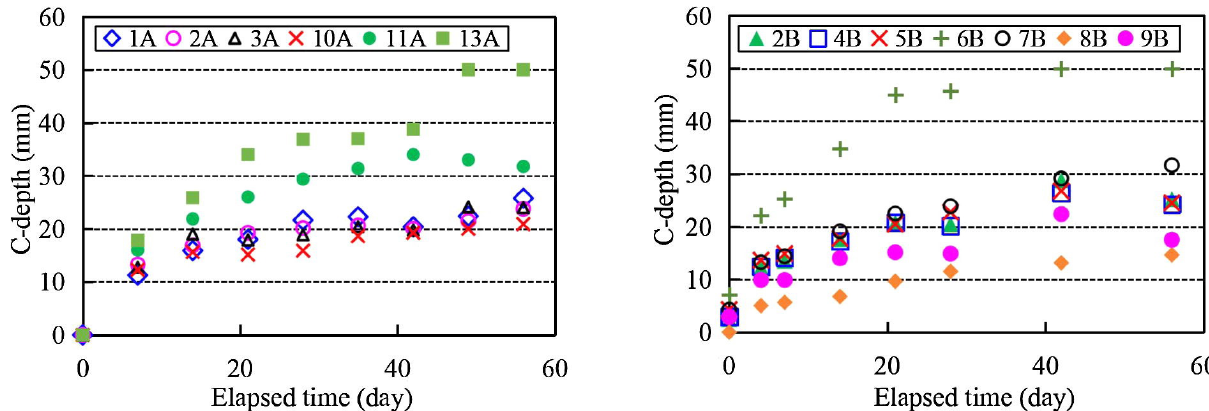
Figure 4: Relationship between the carbonation depth of GP concrete and the elapsed time [40]